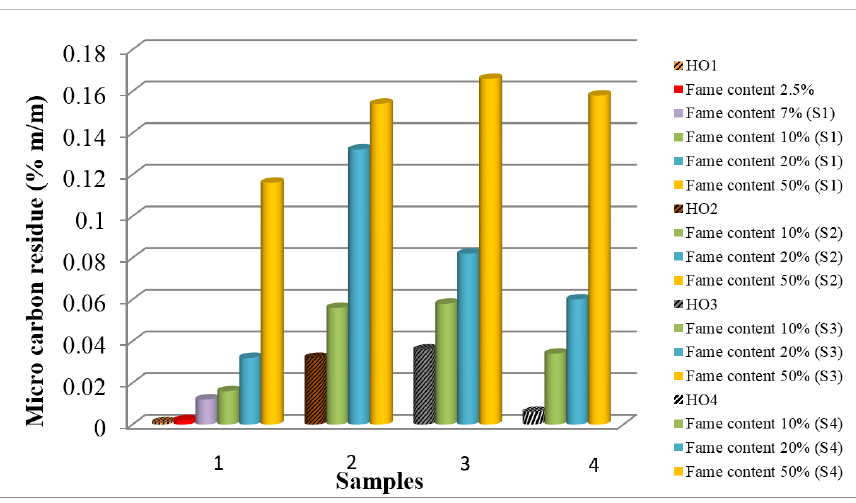
Figure 2. Micro carbon residue (MCR) of oil samples.